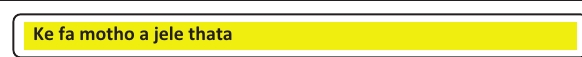
FIGURE 14: Dikarabo.